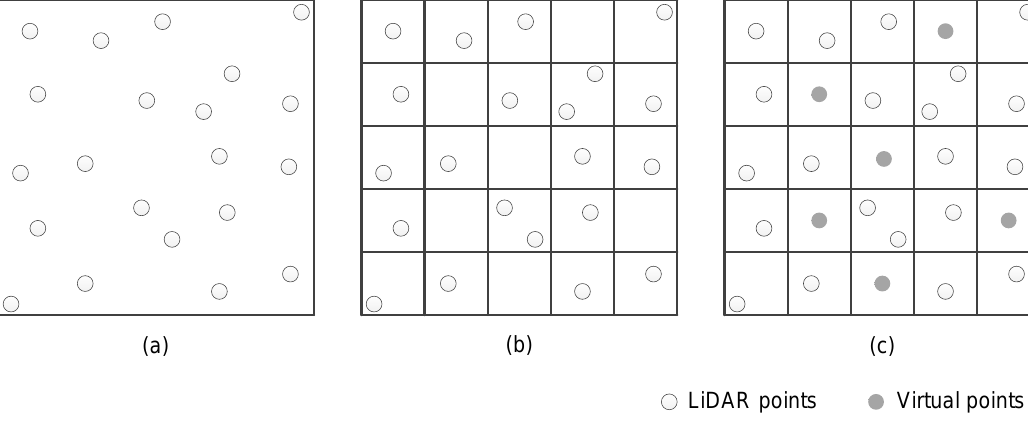
Figure 1. Organizing point clouds with a grid index: ( a ) input point clouds; ( b ) constructing a grid index on point clouds; and ( c ) filling empty grid cells with virtual points.